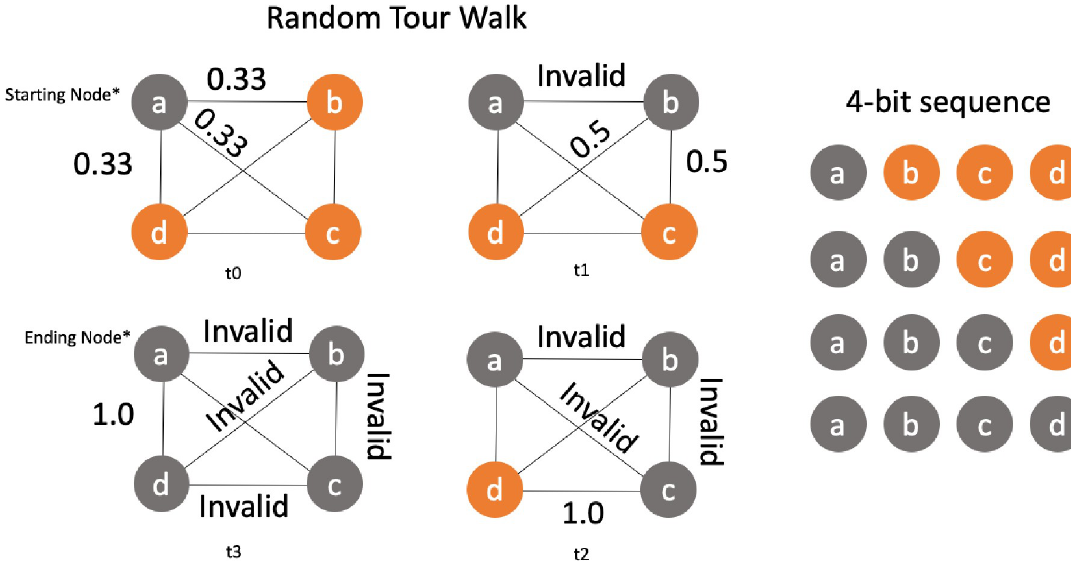
Fig 26. Tour construction for a weighted graph with a probability function p 2